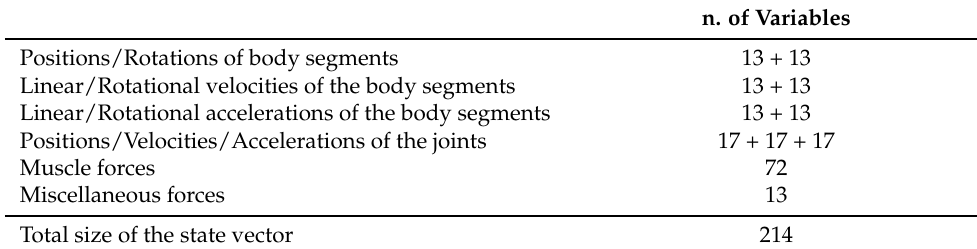
Table 3. The state variables of the human musculoskeletal model.